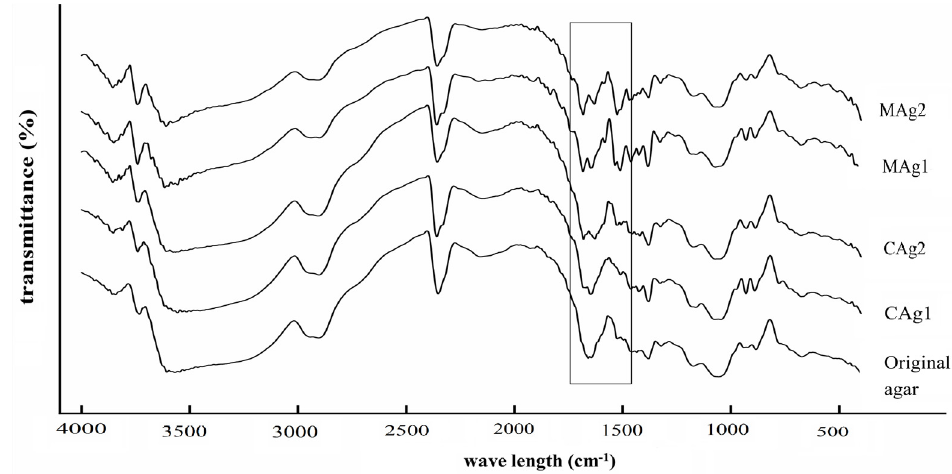
Figure 2. FT-IR spectra of unmodified and carboxymethyl agar. CAg1 and CAg2, carboxymethyl agar prepared using the conventional method, with DS of 0.25 and 0.47, respectively; MAg1 and MAg2, carboxymethyl agar prepared using the microwave-assisted method, with DS values of 0.25 and 0.48, respectively.